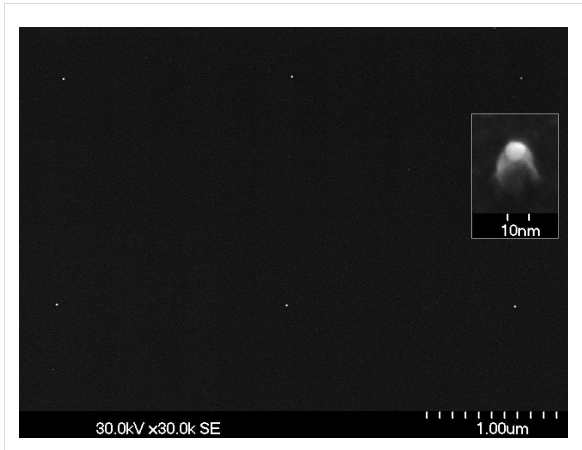
Figure 4: SEM image of two squares of nanopillars as obtained after RIE with single Au NPs, arranged in a square, as etching masks (step 5 in Figure 2). Distance between pillars: 1.8 μ m. Inset: magnified SEM image (tilted by 30°) of one nanopillar with residual Au mask as cap.